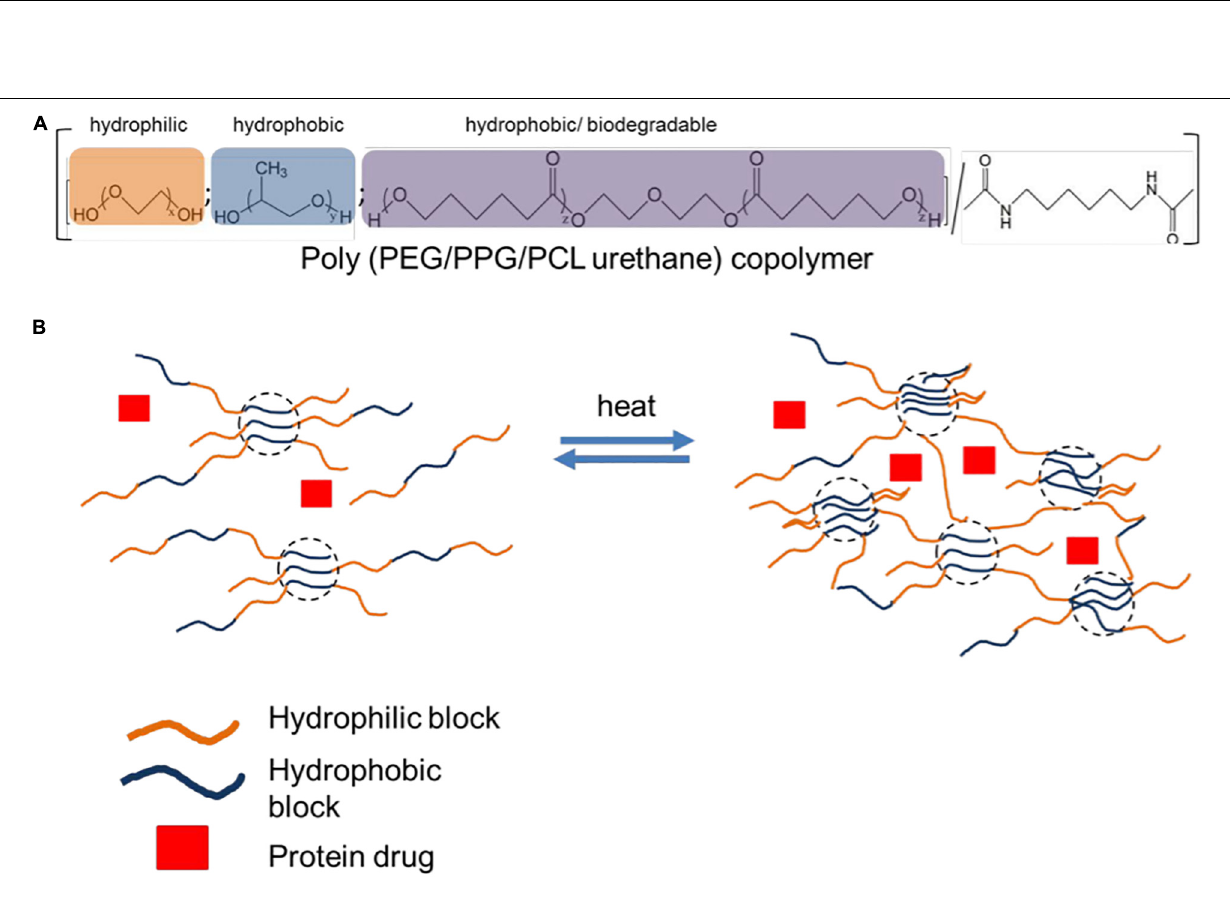
FIGURE 9 | Thermogelling polyurethane copolymer for protein delivery. (A) Schematic of polyurethane copolymer composition based on function. (B) Protein drug is mixed with polyurethane copolymer. Upon heating, the multiblock copolymer is able to generate crosslinks and form a hydrogel under mild conditions to encapsulate protein drug. Reproduced with permission from Royal Society of Chemistry, Xue et al.